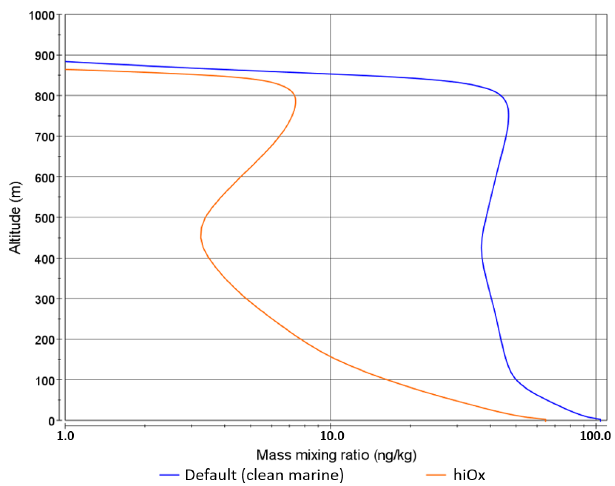
Figure 12. Vertical profiles of equilibrium monoterpene mass mix- ing ratios rising from the maximum flux observed by Kim et al. (2017) with higher and lower oxidant